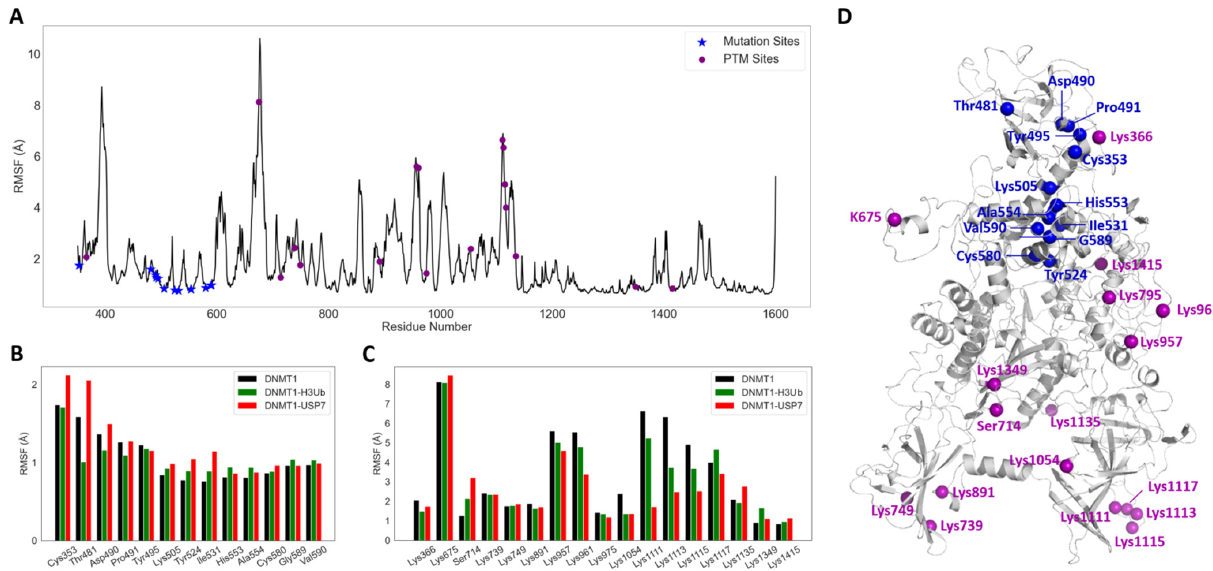
Figure 5. Residue fluctuations of three DNMT1 systems. ( A ) RMSF values per residue based on the MD simulation of Apo-DNMT1. RMSF values for each ( B ) disease mutation and ( C ) PTM in three DNMT1 systems. ( D ) Key mutations and PTMs are indicated on the DNMT1 structure.